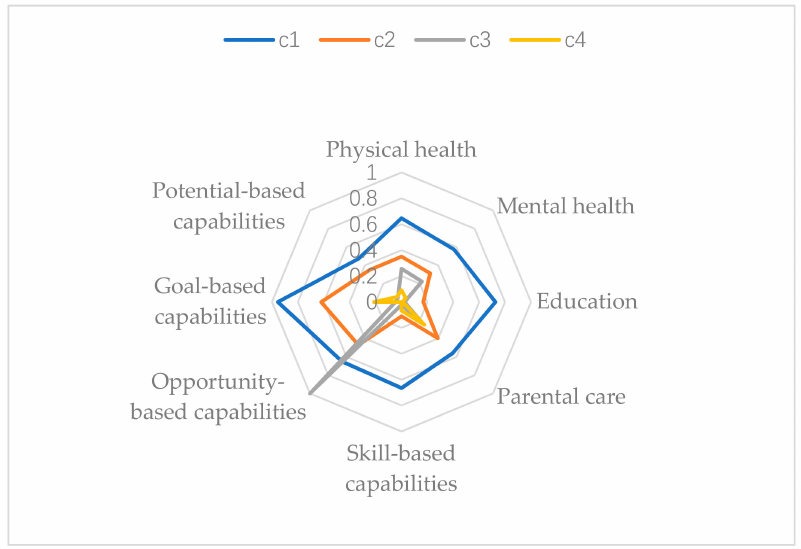
Figure 1. Probability scale according to latent classes. Table 4. Results in probability